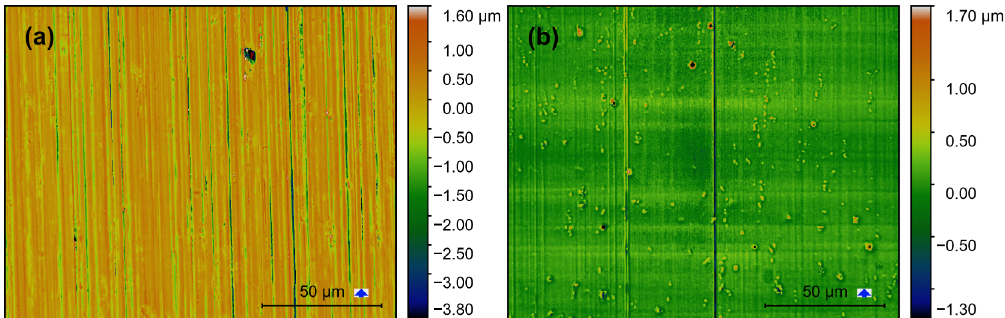
Figure 8. Confocal images of AA6082 surfaces milled with f z = 3µm: ( a ) SC-tool, ( b )